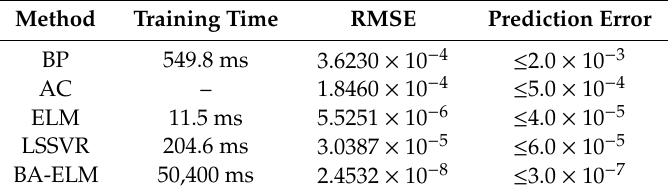
Table 4. Comparison of the BA-ELM compensation method with other compensation